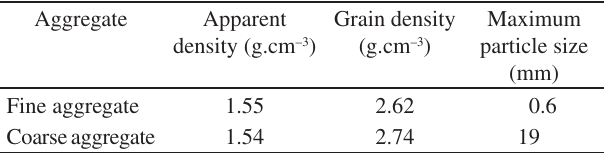
Table 1. Physical properties of the aggregates.